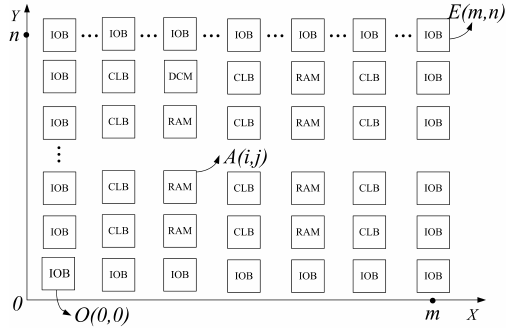
Figure 7. An FPGA-based two-dimensional coordinate